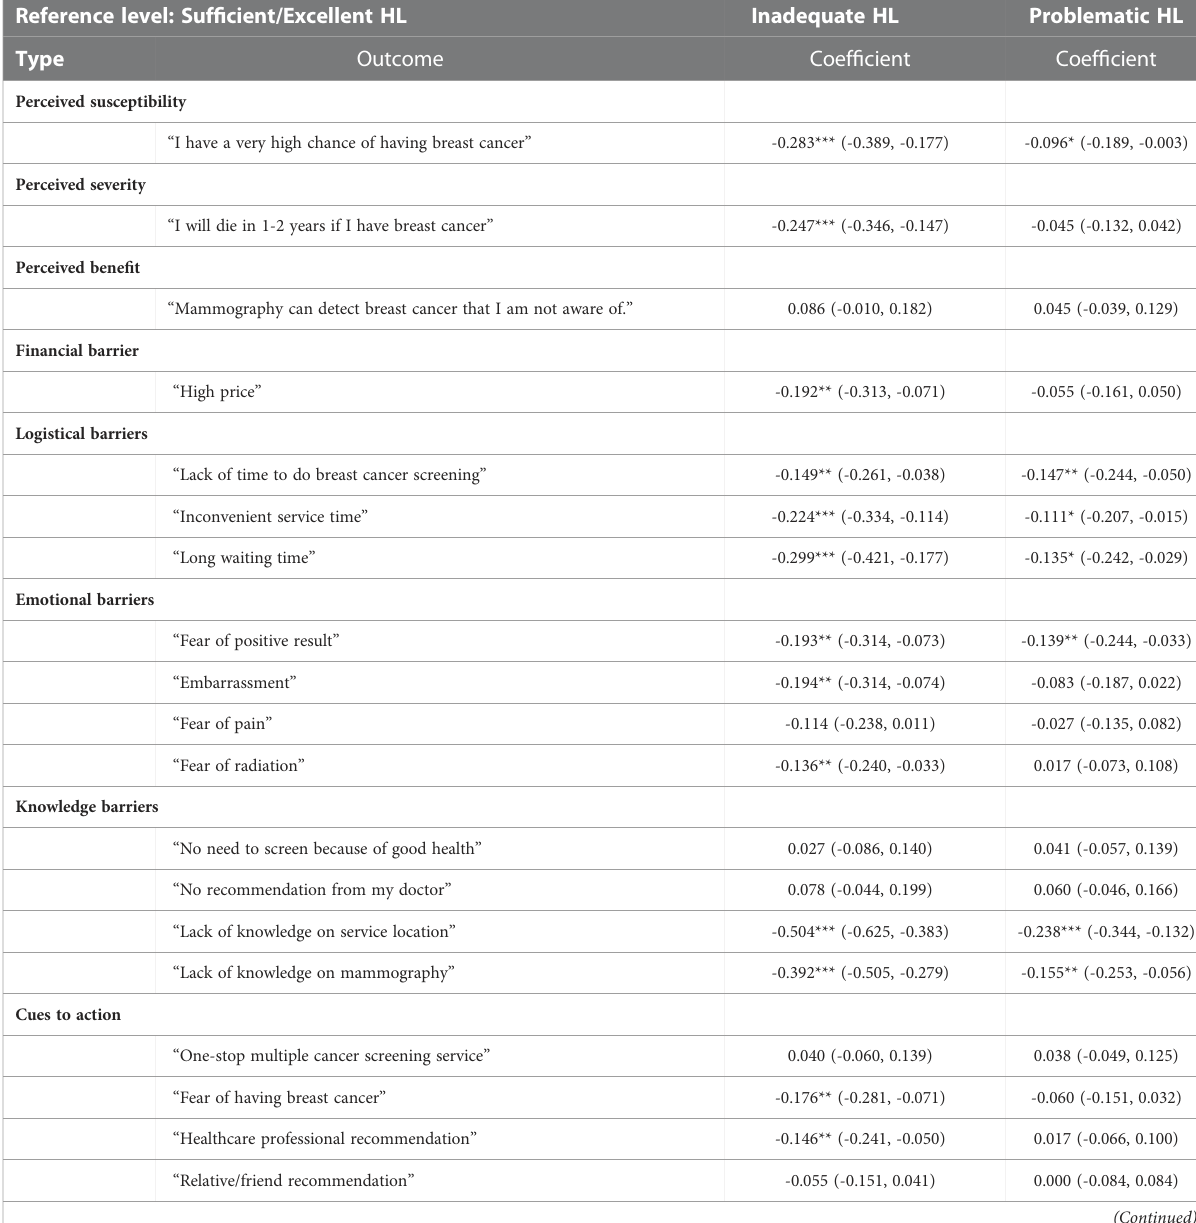
TABLE 2 Associations between screening-related perceptions and health literary